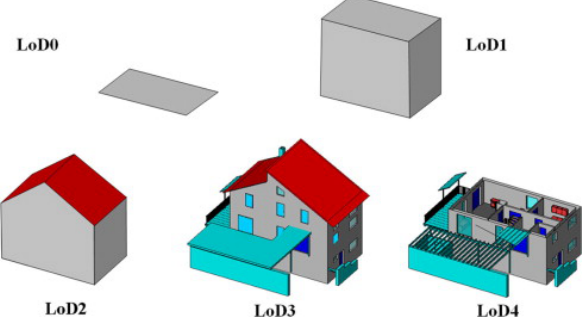
Figure 36: Levels of Detail (LoD0 – LoD4) defined in CityGML